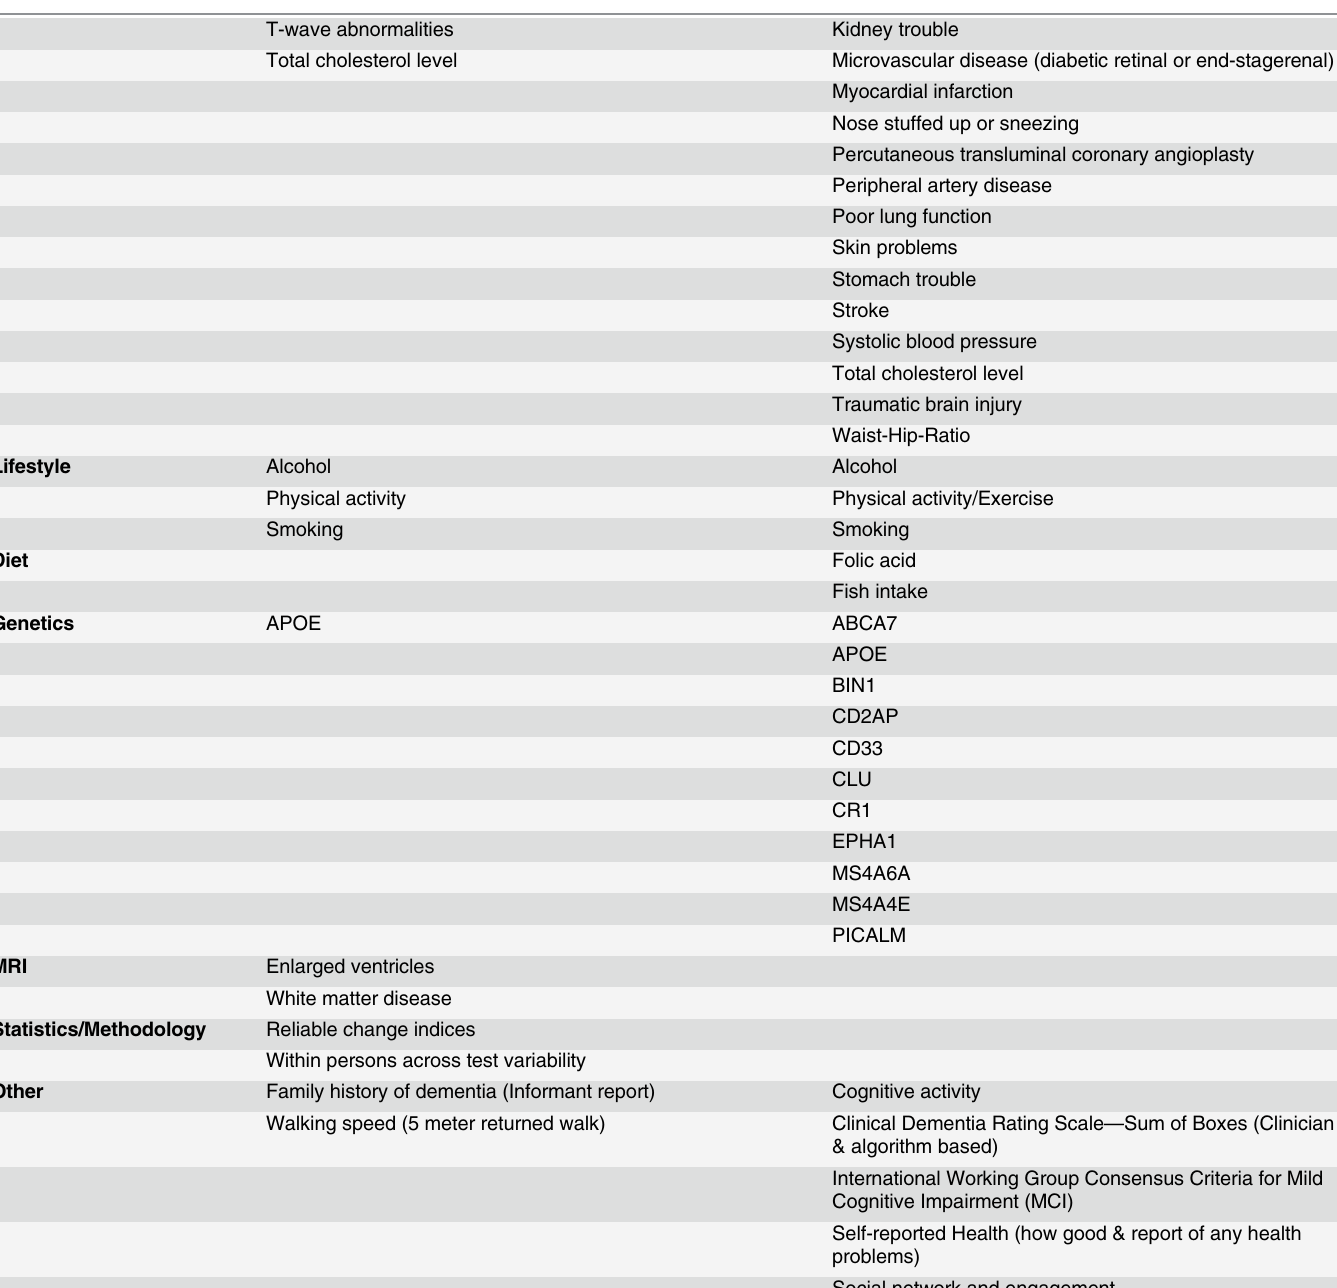
Abbreviations: ADAS-Cog Alzheimer's Disease Assessment Scale-cognitive; IADL Instrumental Activities of Daily Living; CAMCOG Cambridge Cognitive Examination; CASI The Cognitive Abilities Screening Instrument; CERAD Consortium to Establish a Registry for Alzheimer ’ s Disease; CES-D Center for Epidemiologic Studies Depression Scale ; DSM-III-R Diagnostic & Statistical Manual of Mental Disorders – 3rd Edition Revised; IDSR-7 Intra- categorical Delayed Selective Reminding Test; MMSE Mini Mental State Examination; WAIS Wechsler Adult Intelligence